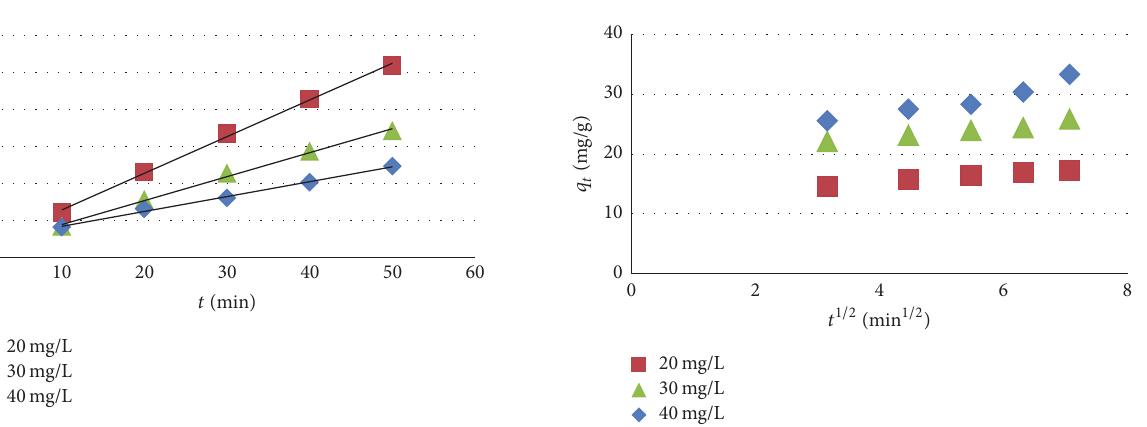
Figure 13: Pseudo-second-order kinetic plot for adsorption of MB on DNPH- 𝛾 -alumina nanoparticles at different initial concentra- tions.